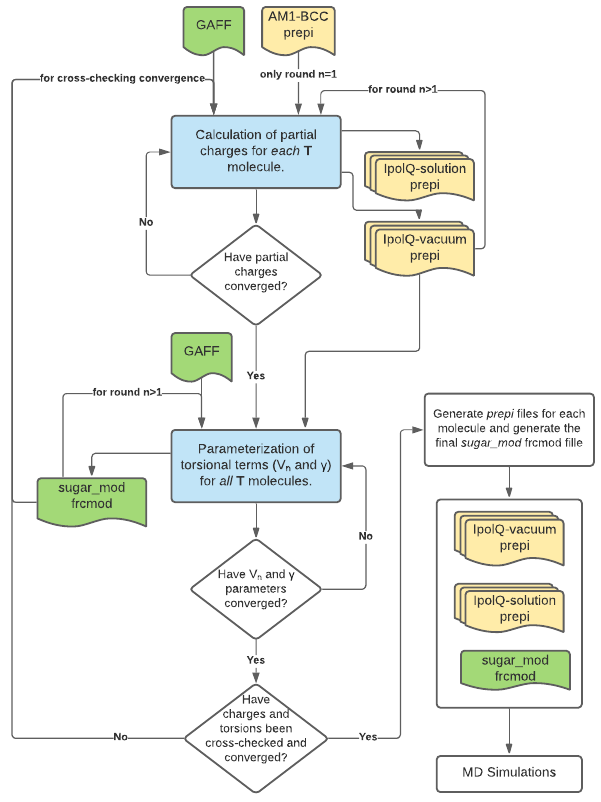
Figure 6. Workflow used to calculate implicitly polarized and gas-phase partial charge sets for each molecule, and, the sugar_mod frcmod file containing the reparameterization of V n and γ for the dihedrals of interest. The processes in blue have been explained in detail in Sections 3.2.1 and 3.2.2 as well as Figure S4. The green and yellow files are force field and prepi files,